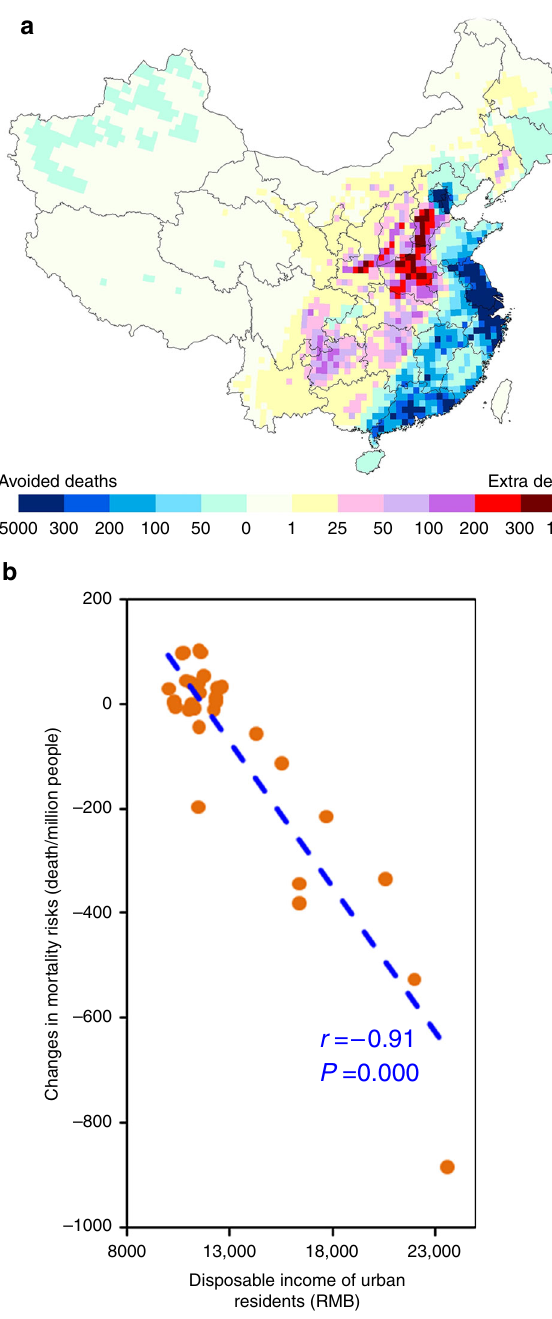
Fig. 3 Effects of interprovincial trade on premature deaths attributable to ambient PM 2.5 across China. a geographical distribution of mortality, with blue and red/lavender/yellow indicating regions of avoided deaths (a bene fi t) and increased deaths (a disbene fi t) from interprovincial trade, respectively; b increased (positive values) or avoided (negative values) mortality risk (deaths per million people) of provinces by economic development level, indicated by per capita disposable income of